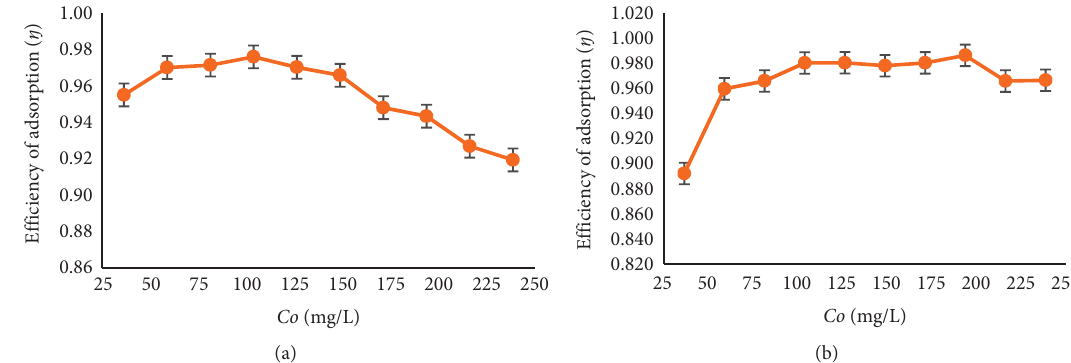
Figure 6: Nance seeds: effect of initial concentration ( C 0 ) of MB on the efficiency of adsorption at pH 7 (a) and pH 10 (b).